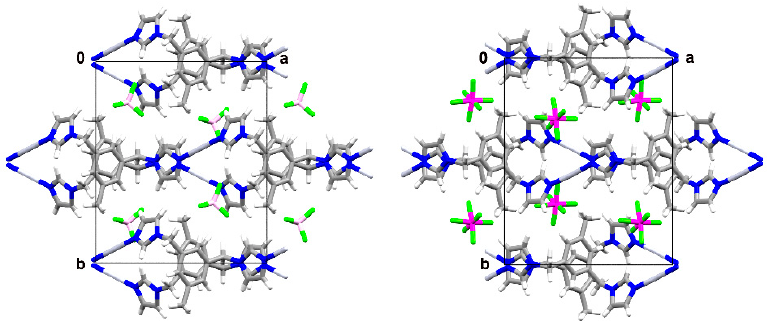
Figure 5. Schematic representation of the crystal packing in 1 ( left ) and 2 ( right ), shown along the c axis.